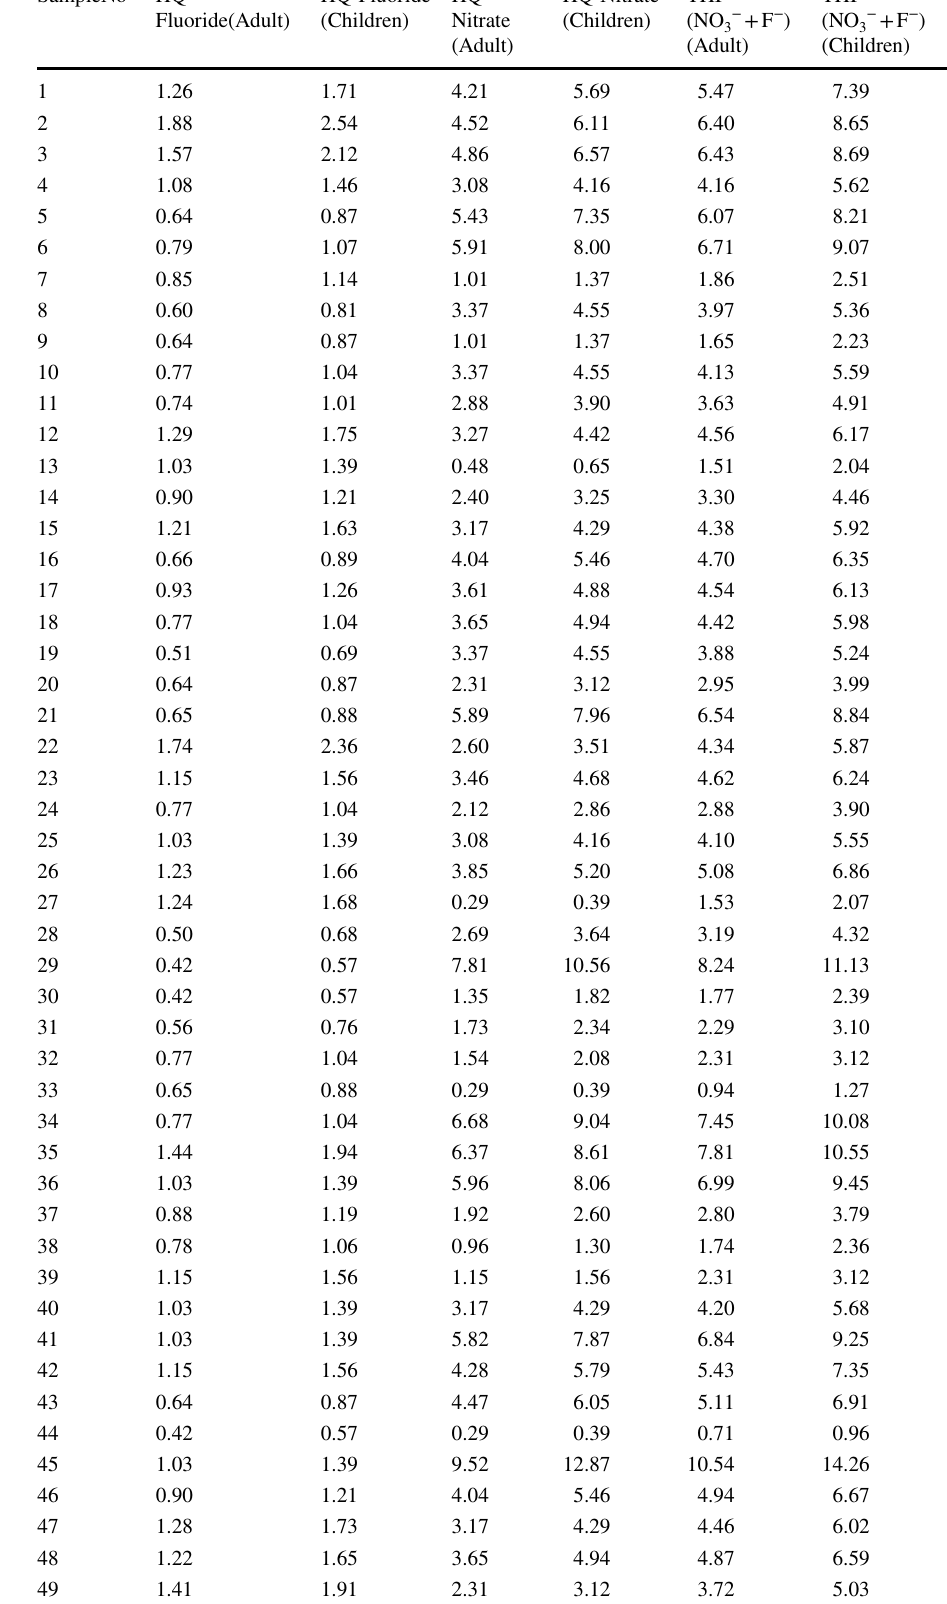
and Total Hazard Index (THI) for fluoride and nitrate in Adults and Children in the study area of pre-monsoon season